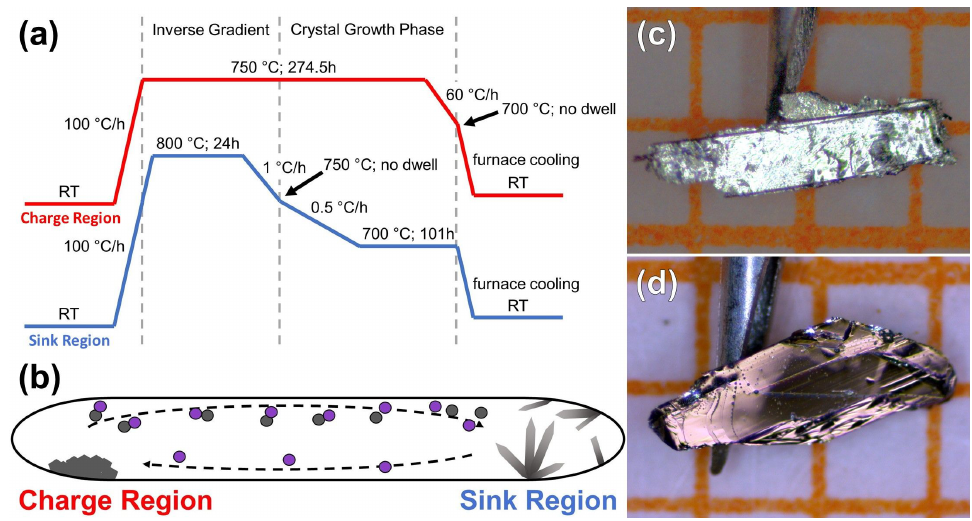
Figure 2. ( a ) Graphical illustrations of the temperature profile for the CVT growth of AgCrP 2 S 6 and ( b ) schematic drawing of an ampule during CVT. Arrows indicate the mass flow of the volatile transport species (top) and the flow of the released transport agent back to the charge (bottom). ( c , d ): As-grown crystals of AgCrP 2 S 6 . A orange square in the background corresponds to 1mm × 1mm for